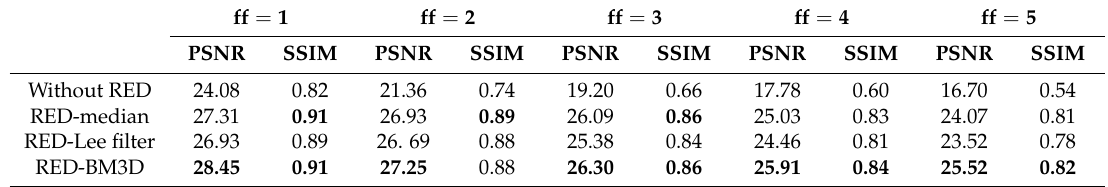
Table 2. PSNR(dB) and SSIM of the proposed algorithm with different denoisers and varying amounts of speckle